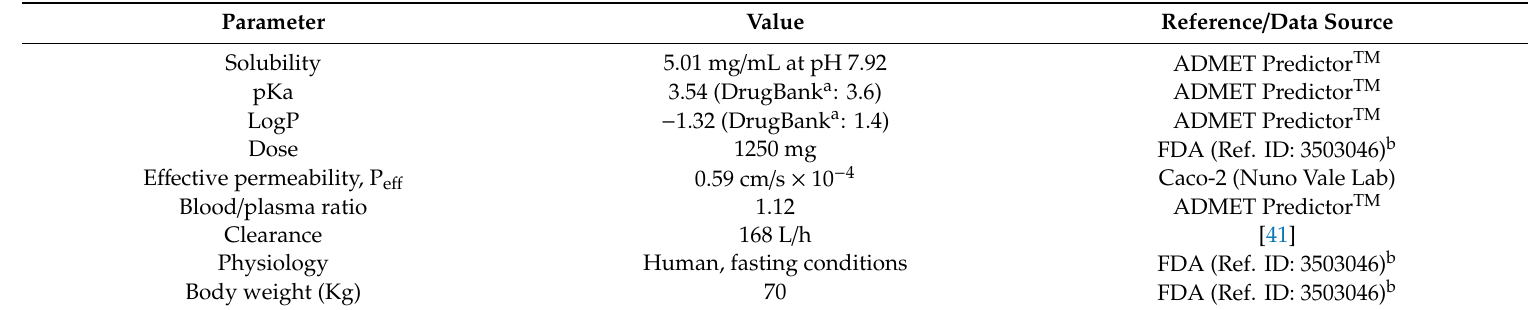
Table 5. Input data used in GastroPlus ™ to simulate plasma concentration of GEMZAR ® .